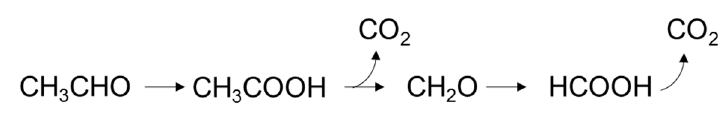
Figure 1. The proposed reaction mechanism for the photocatalytic degradation of acetaldehyde by TiO 2, under weak UV illumination. First, acetaldehyde is oxidized to acetic acid, which can be transformed into CO 2 and formaldehyde. Formaldehyde is then oxidized to formic acid and eventually to CO 2 .